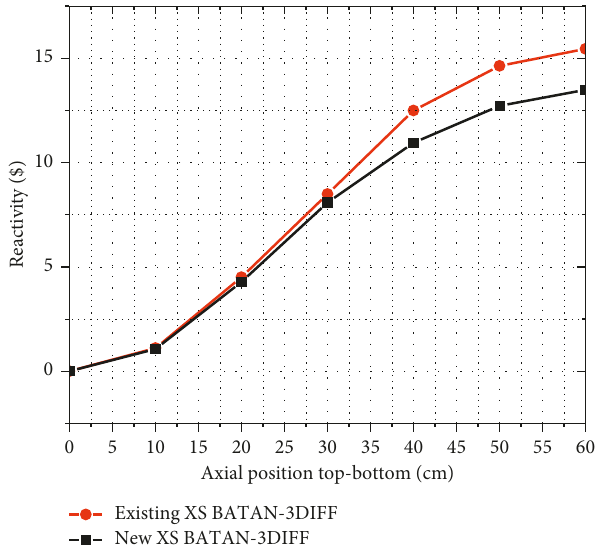
Figure 3: Integral control rod worth curve for reactivity insertion under transient conditions.